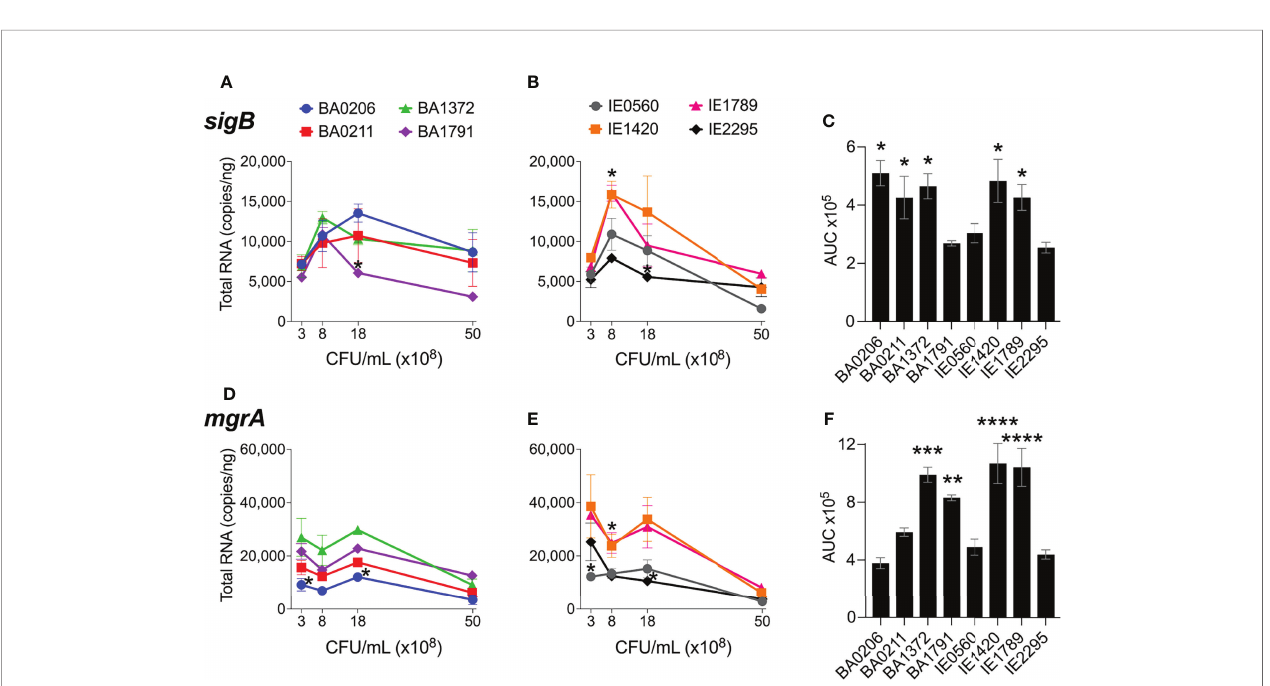
FIGURE 6 | sigB and mgrA expression in S. aureus CC5 isolates. Quantitation of S. aureus CC5 gene expression during growth in TH broth by RT-qPCR standard curve quantitation method. (A, B) sigB expression and (D, E) mgrA expression at indicated cell densities. Error bars (standard deviation) not shown are smaller than symbol. Asterisks indicate data points signi fi cantly different than the rest at a speci fi c cell density. (C, F) Area under the curve (mean ± SEM). Data is the result of three biological replicates. *, p < 0.05, **, p < 0.005, ***, p < 0.0005, one-way ANOVA with Holm-S ̌ ı ́ da ́ k ’ s multiple comparisons test across strains.